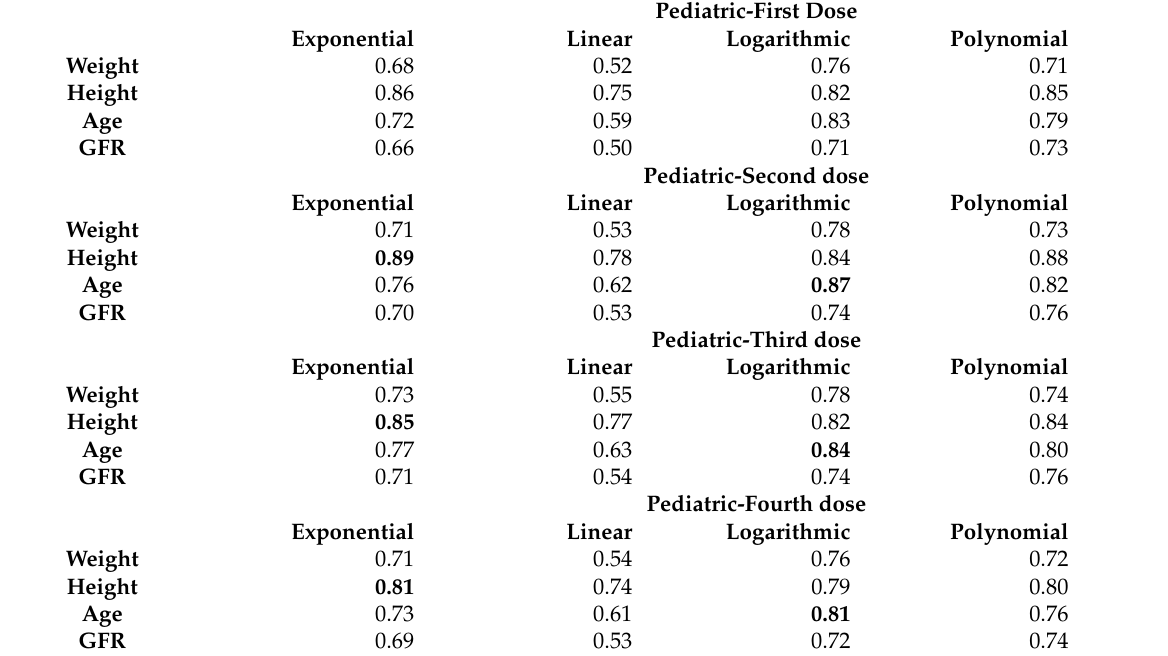
Table 4. The reported R 2 value from the five different regression models for the parameters of the pediatric population and the drug peak concentration after each dosing. Pediatric-First Dose Exponential Linear Logarithmic Polynomial